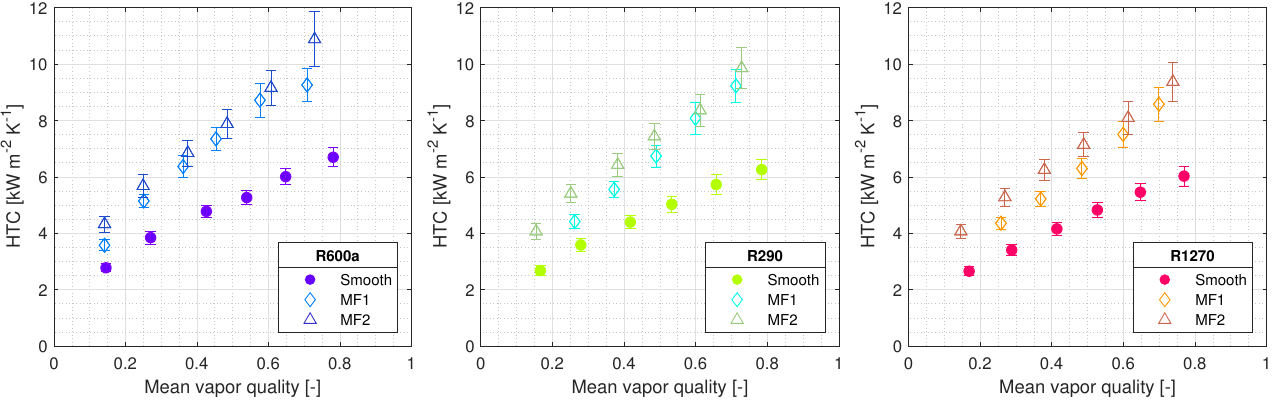
Figure 7. Effect of internal surface enhancement on HTC for R290, R1270, and R600a, G = 300 kgm − 2 s − 1